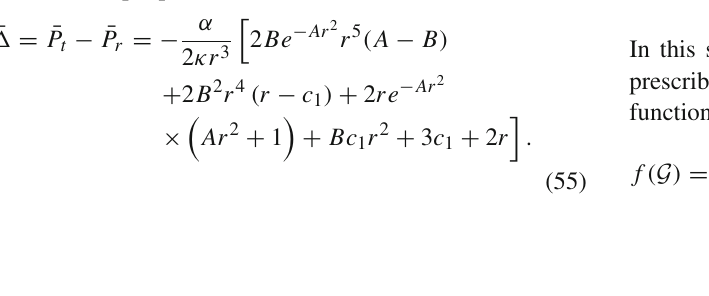
with anisotropic